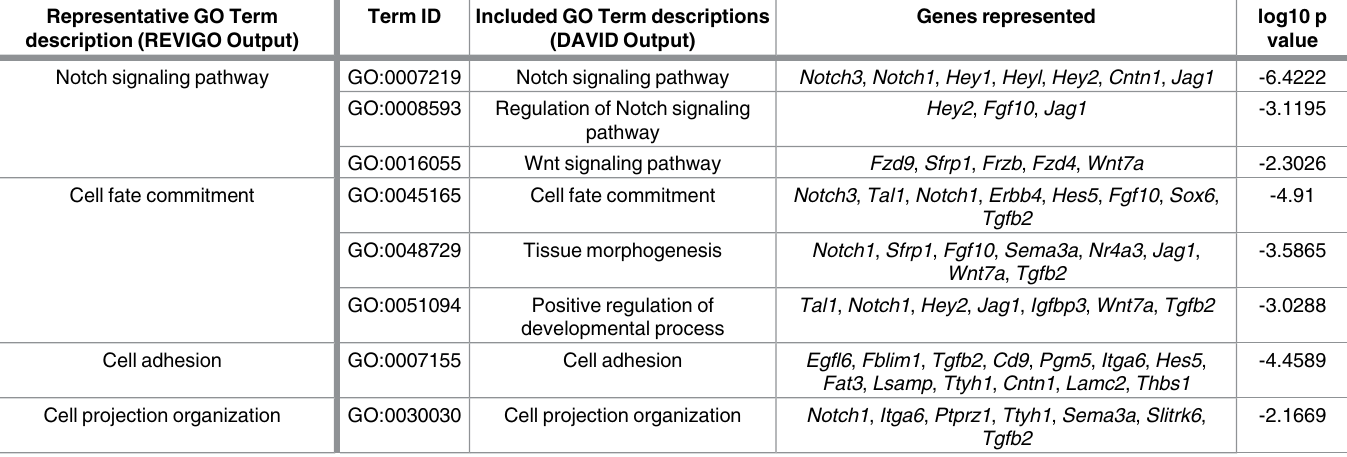
Table 11. Biological processes(BP) GO terms represented in the list of transcripts down-regulated after DAPT treatment of P0 Lfng-GFP + cells that were also enriched in P1 Lfng-GFP +